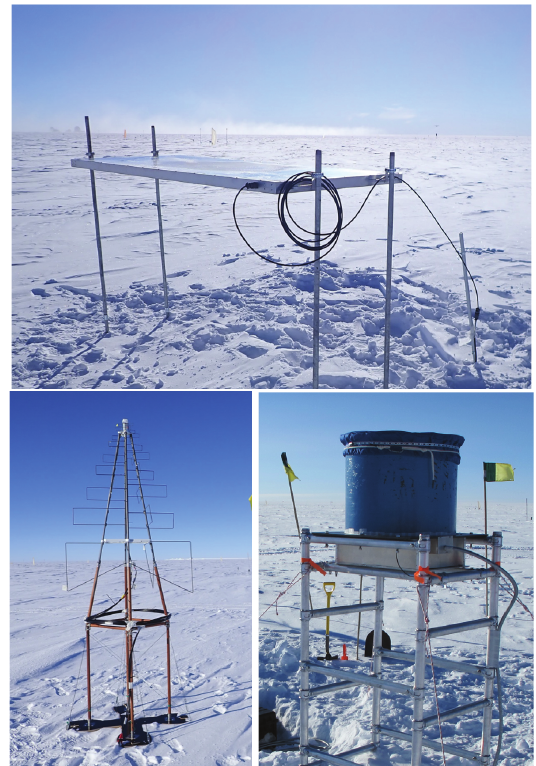
Figure 12: Surface enhancement prototype detectors - (Top) Surface scintillator panel [16–18], (Bottom left) Sur- face Radio antenna [17, 18] (Bottom right) Imaging air- Cherenkov telescope IceAct [19–21]. Pictures by Yuya Makino, IceCube / NSF